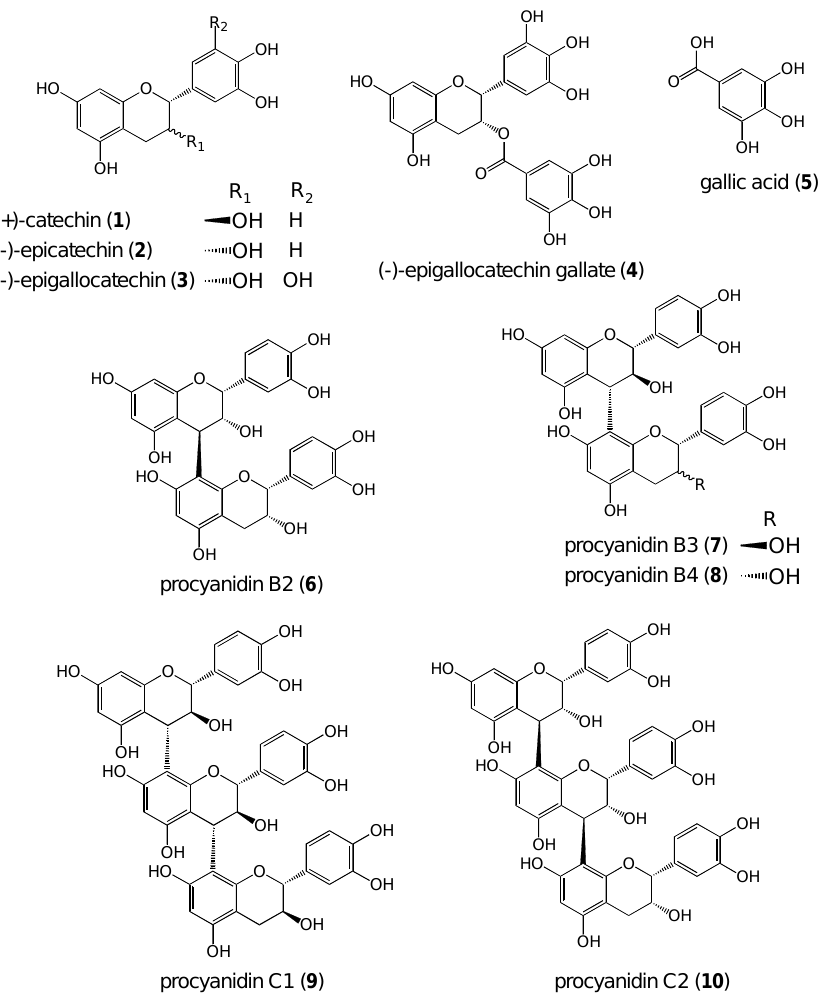
Figure 1. Structures of